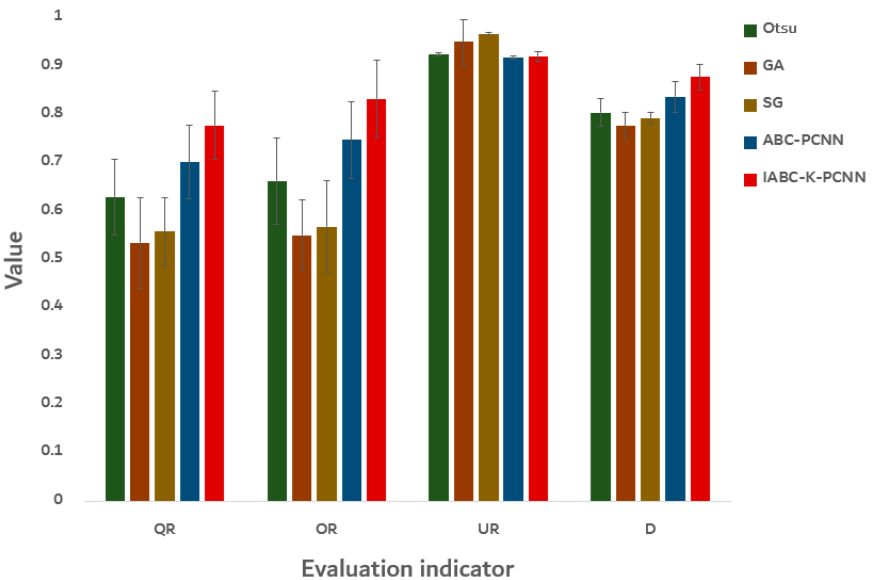
Figure 10. Evaluation of segmentation results. The color column is the average value, and the black line is the error line. QR, OR, UR, and D represent the evaluation indicators of Otsu, GA, SG, ABC-PCNN, and IABC-K-PCNN, respectively.